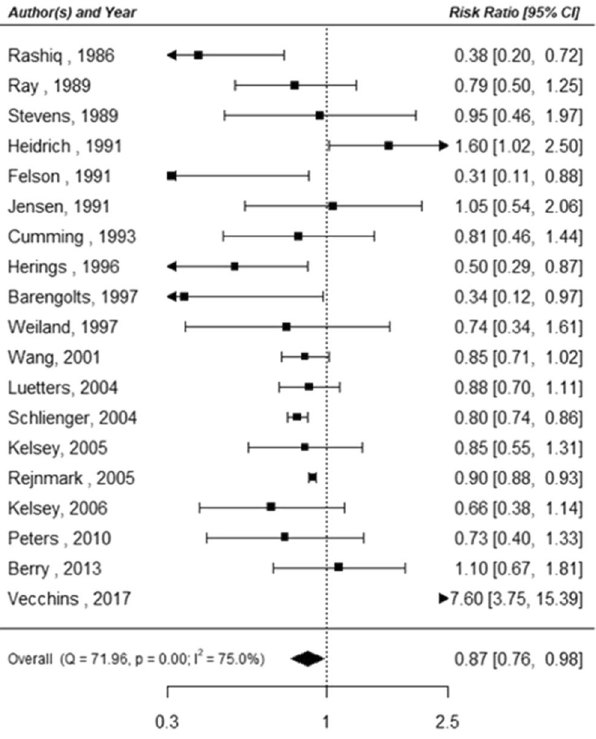
Figure 2. Association between thiazide use and fracture risk for case-control studies analyzed using the classical meta-analysis approach.